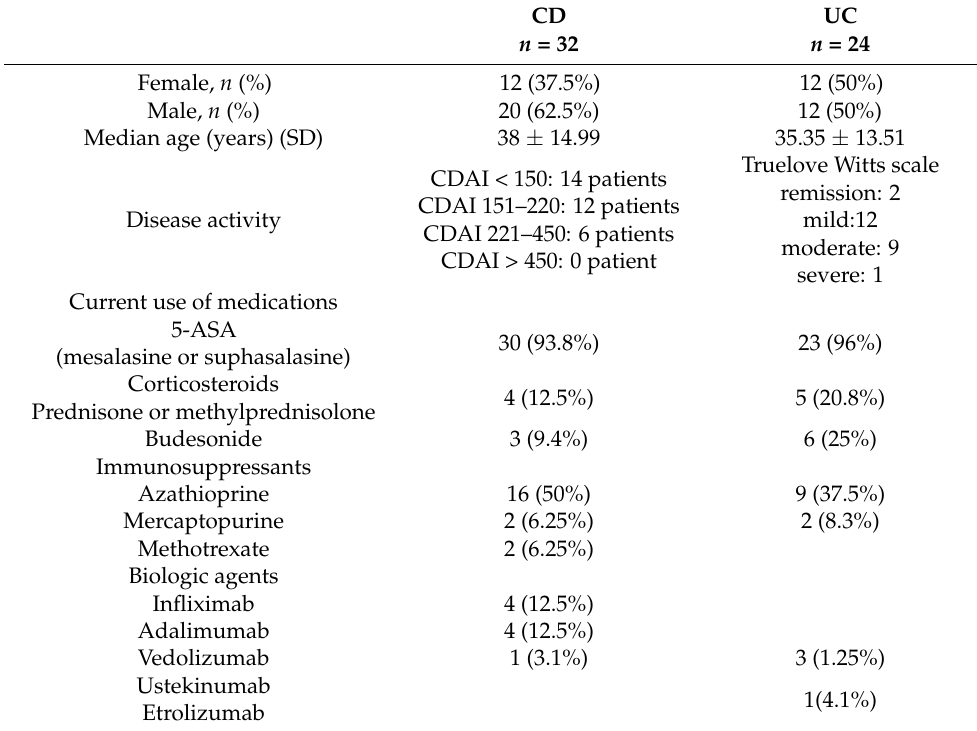
Table 1. Patient demographics at